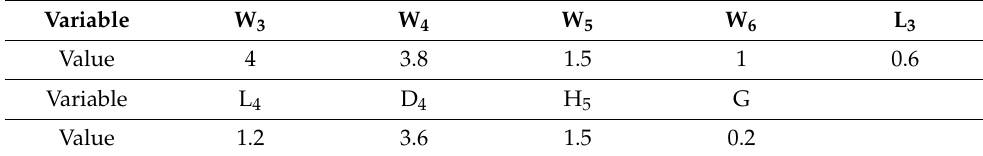
Figure 2. The AMC designs: ( a ) unit cell and ( b ) 2 × 3 structure. Table 1. The values of AMC variables (unit: mm). Table 1. The values of AMC variables (unit: mm).